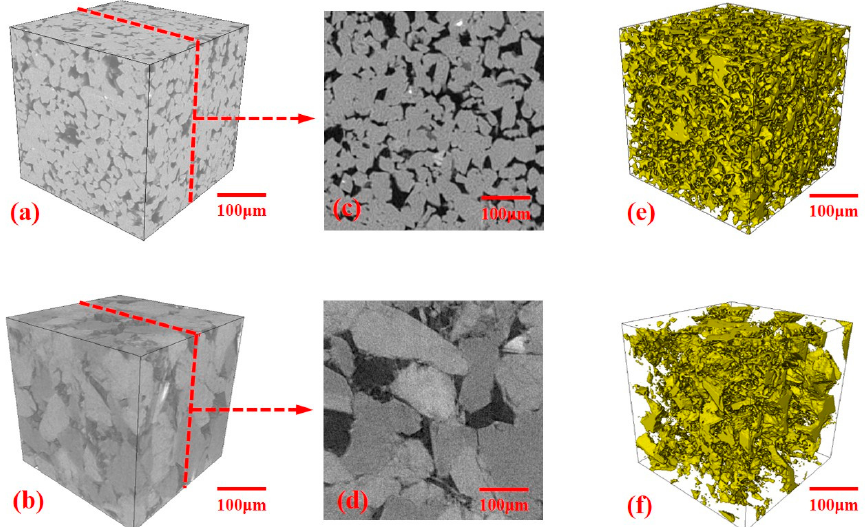
Figure 2. Segmentation and reconstruction of the specimens W1 and S1: ( a – b ) The volume of interest (VOI) of 600 × 600 × 600 voxels selected from the two specimens; ( c – d ) Two-dimensional CT slice of the two specimens; ( e – f ) Three-dimensional segmented pore volumes of the two specimens. Table 2. The evolution of porosity of two kinds of sandstone specimens based on the CT images with different thresholds. Threshold Porosity Threshold Porosity W1 S1